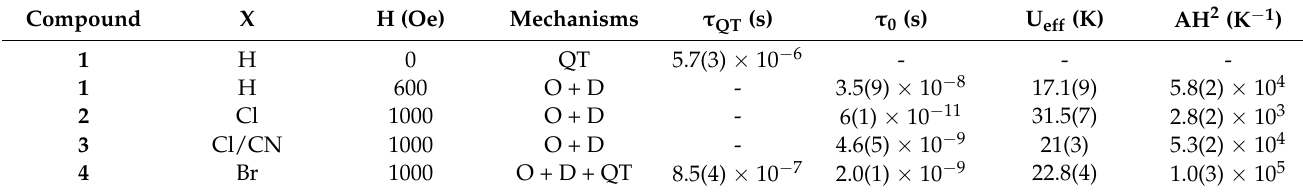
Figure 11. Arrhenius plot of the relaxation times for compound 1 with H DC = 0 and 600 Oe, and for compounds 2 and 3 with H DC = 1000 Oe. Solid lines are the best fit to the general model (Equation (2)) with different terms (see text and Table 2). Table 2. Magnetic parameters for the relaxation processes in compounds 1 – 4